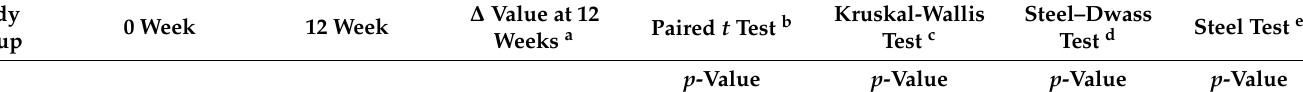
Table 2. The characteristics and parameters at baseline (week 0) and week